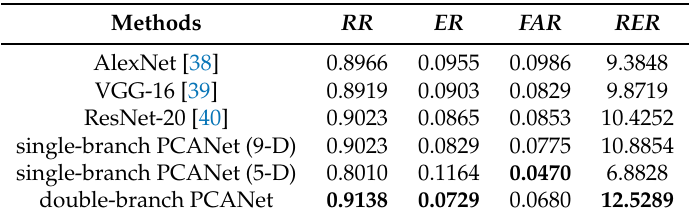
Table 2. Statistical results of different network